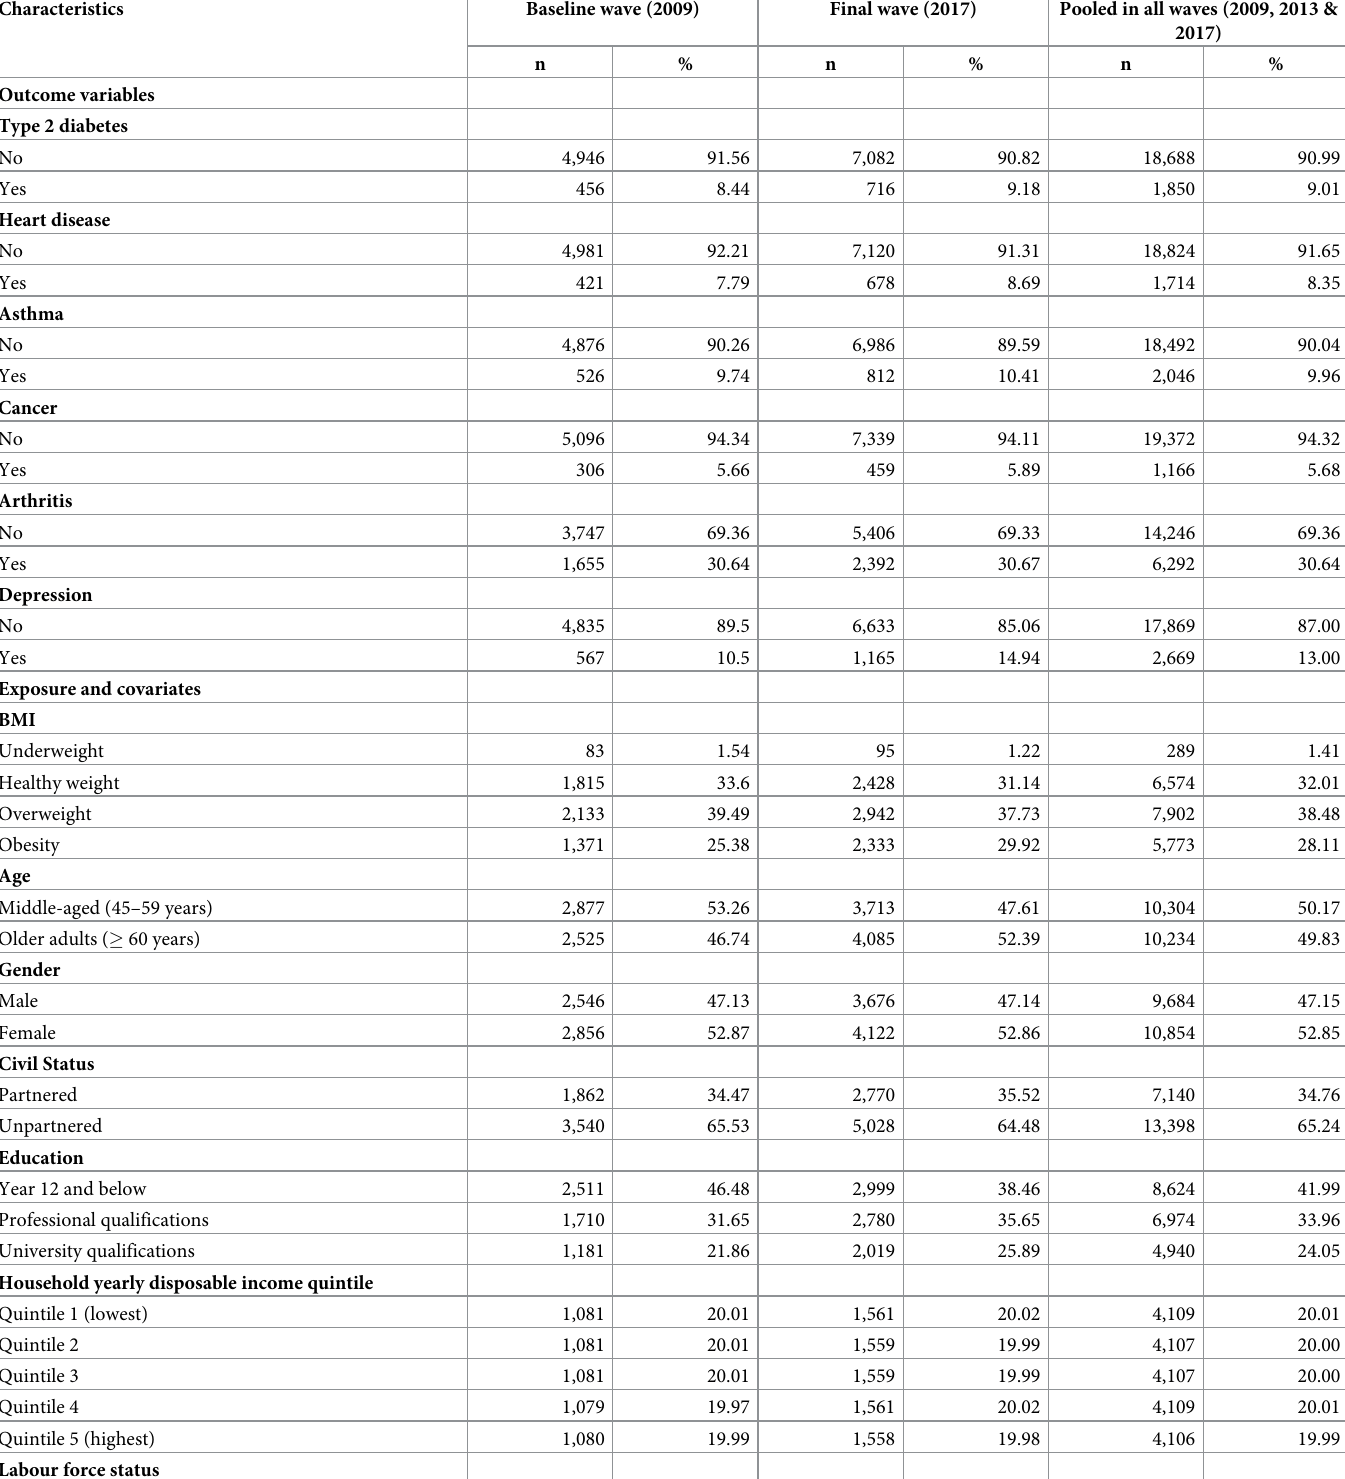
Table 2. Distribution of the analytic sample: Baseline, final and pooled across all waves (persons = 9,822; observations = 20,538).